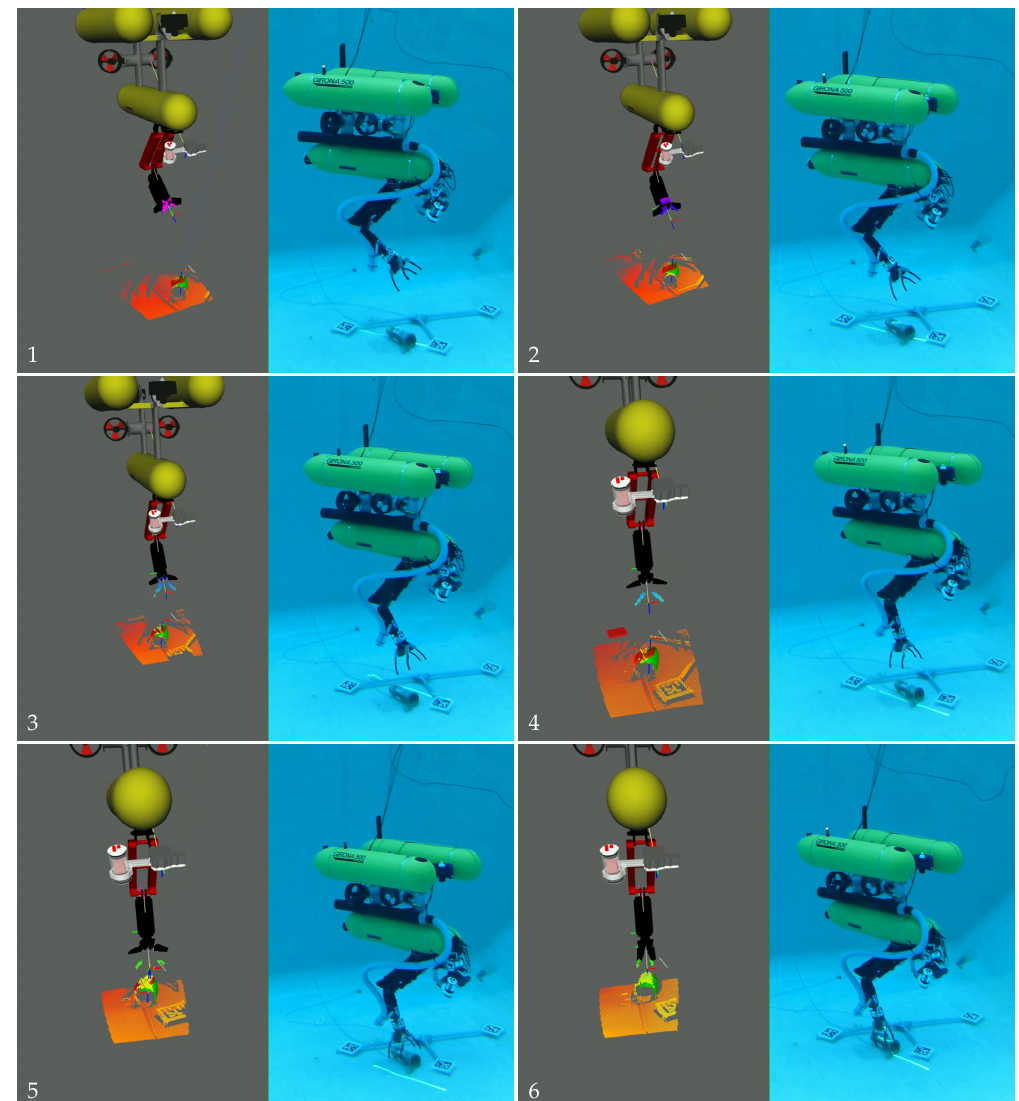
Figure 15. Sequence of images ( 1 – 6 ) of the 3D visualizer alongside the real scenario while the robot approaches and grasps the